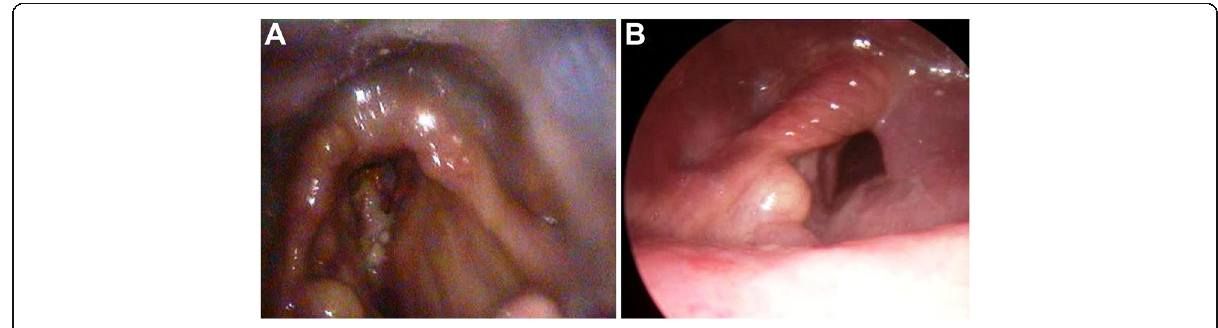
Fig. 1 Preoperative naso-fiberoptic laryngeal examination ( a ). Postoperative naso-fiberoptic laryngeal examination ( b